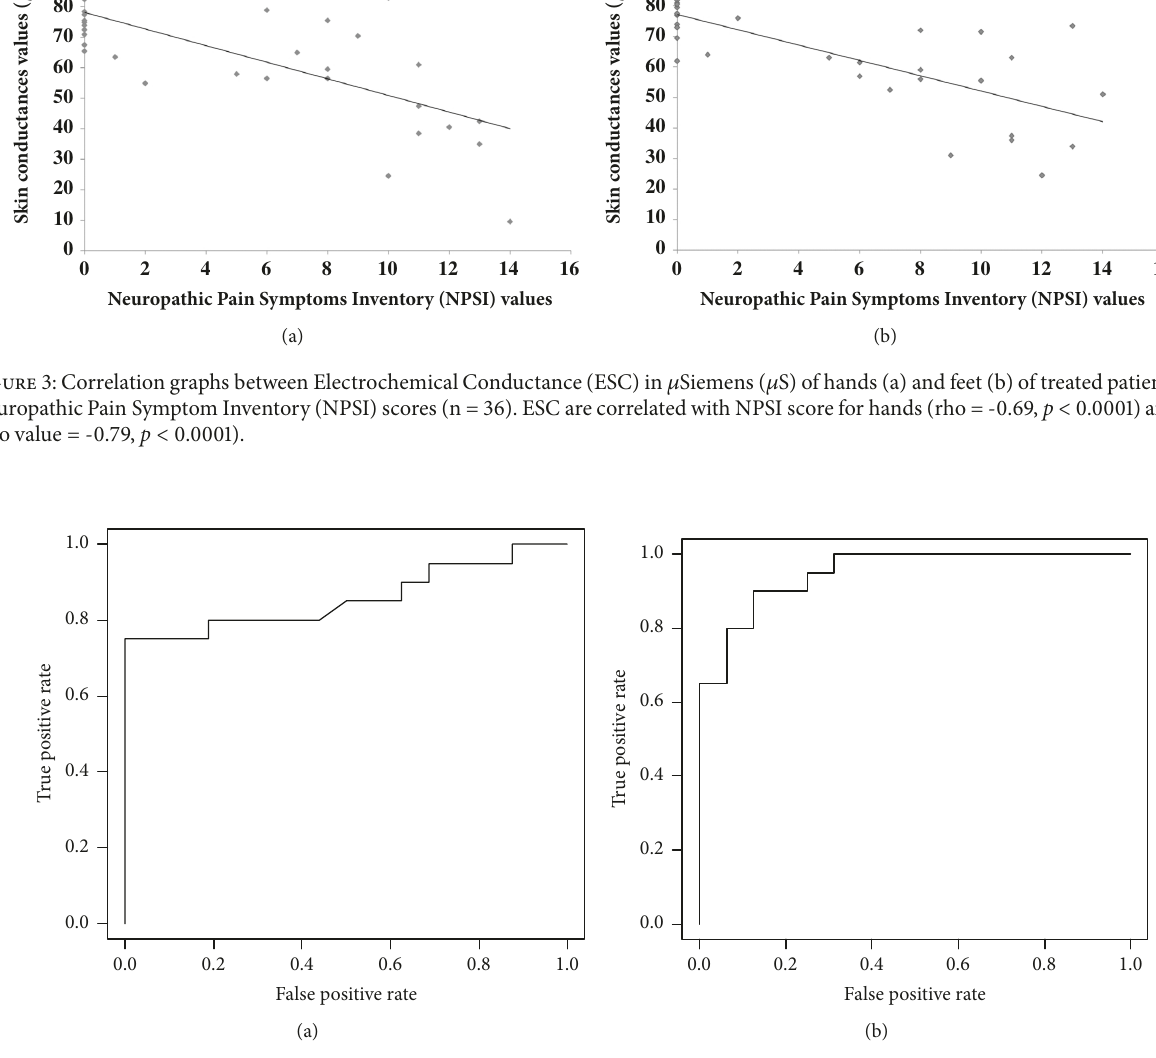
Figure 4: Receiver operating characteristics (ROC) curves for ESC of hands (a) and feet (b) using a positive NPSI score as reference. AUC = 0,86 for (a) and AUC = 0,95 for (b). (20 patients with painful symptoms and 16 patients without painful symptoms).